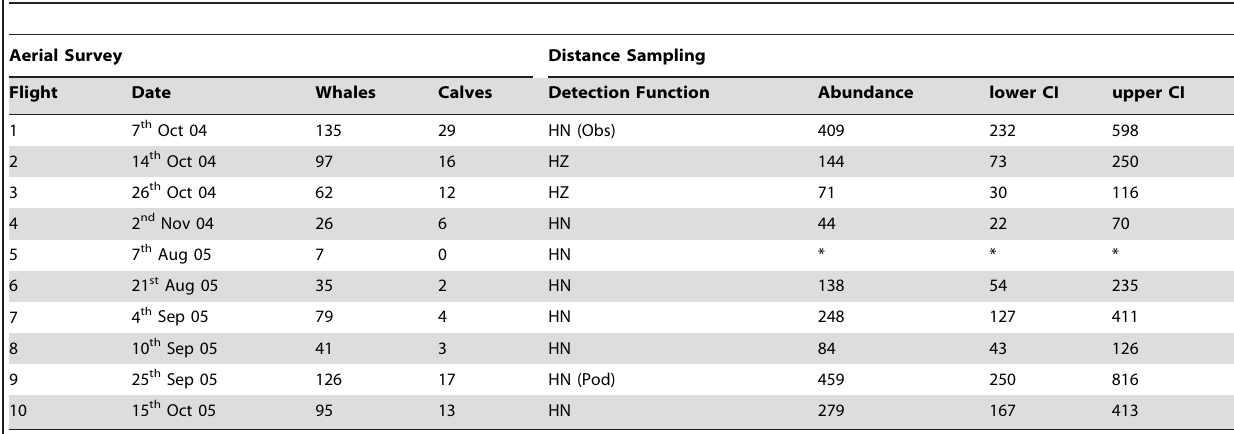
Table 1. A summary of the aerial surveys carried out during the 2004 and 2005 whale season (Aug – Nov) in Exmouth Gulf.